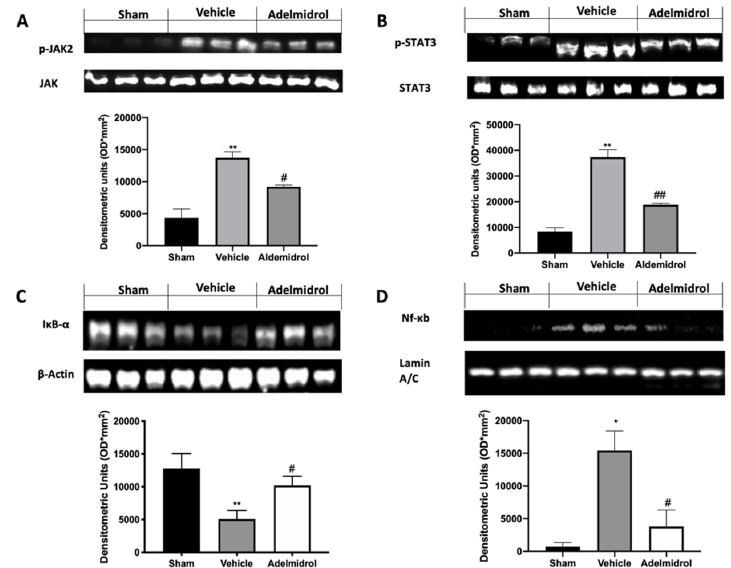
Figure 3. E ff ect of adelmidrol on p-JAK2, p-STAT3, Ikb- α , and NF-kB expression: Western blot analysis Figure 3. Effect of adelmidrol on p-JAK2, p-STAT3, Ikb-  , and NF-kB expression: Western blot of p-JAK2 ( A ), p-STAT3 ( B ), Ikb- α ( C ), and NF-kB ( D ). * p < 0.05 vs. sham + vehicle, # p < 0.05 vs. analysis of p-JAK2 ( A ), p-STAT3 ( B ), Ikb-  ( C ), and NF-kB ( D ). * p < 0.05 vs. sham + vehicle, # p < 0.05 vehicle, ** p < 0.01 vs. sham + vehicle, ## p < 0.01 vs. vehicle. vs. vehicle, ** p < 0.01 vs. sham + vehicle, ## p < 0.01 vs. vehicle.